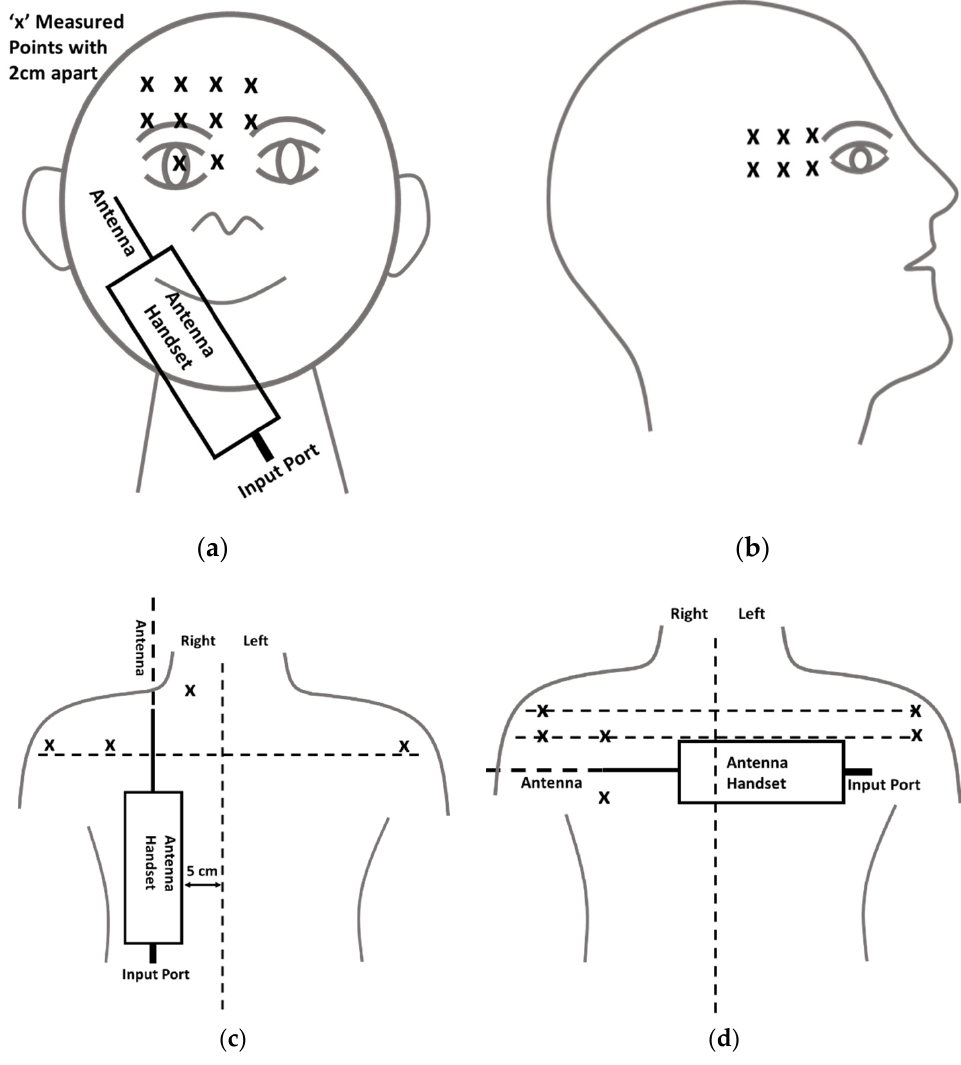
Figure 2. Direct measurements of SAR in the head and body phantoms: ( a ) front view—head measurement points (hand-held position, at an angle in front of the face with the antenna pointing upward and outward to the right), ( b ) head measurement points—side view, ( c ) body probe insertion points for position I, and ( d ) body probe insertion points for Position II.